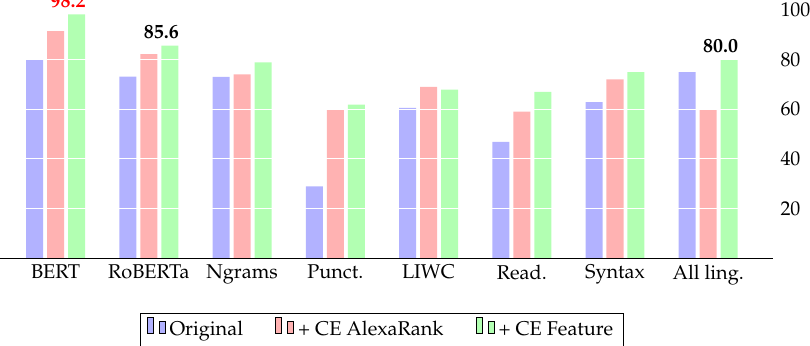
Figure 6. Results on Celebrity dataset ( F 1 score): adding our Cross-lingual Evidence (CE) improves various baseline systems and yields state-of-the-art result with BERT model.